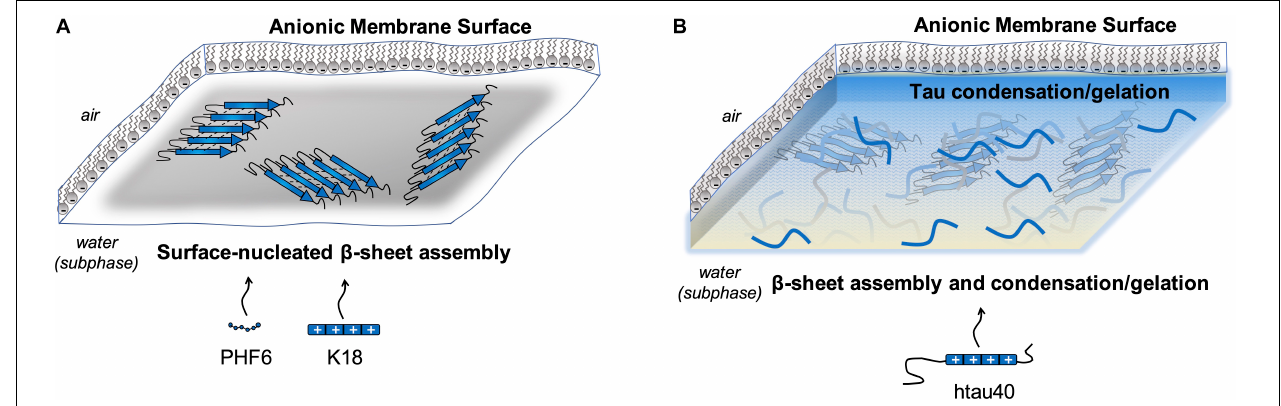
FIGURE 5 | (A) PHF6 and K18 interact with anionic membranes to form β -sheet rich fibrillar structures. (B) Full-length htau40 condenses to form a macroscopic gel when interacting with anionic membranes, in addition to nucleating β -sheet assembly.